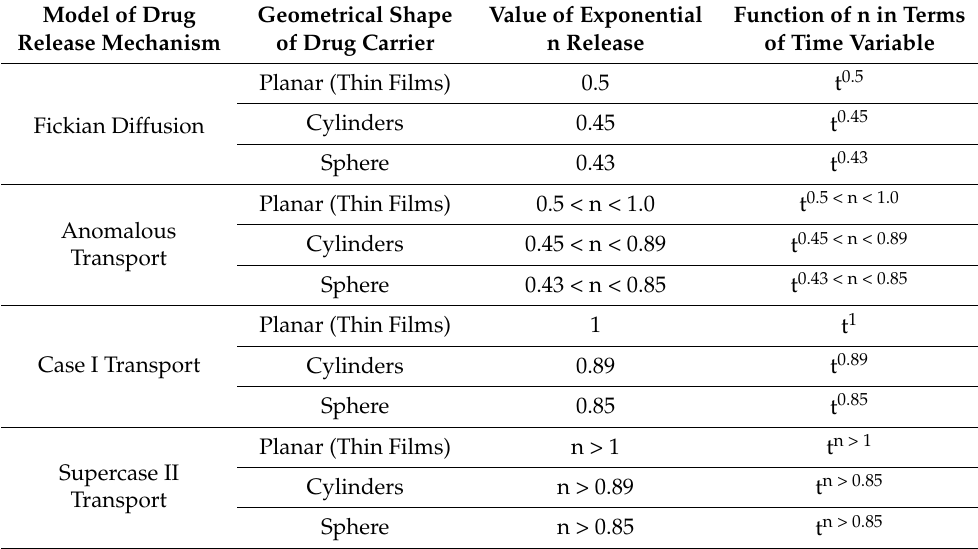
Table 4. The effect of different carrier geometries on the n-value of the Korsmeyer–Peppas model (adapted from